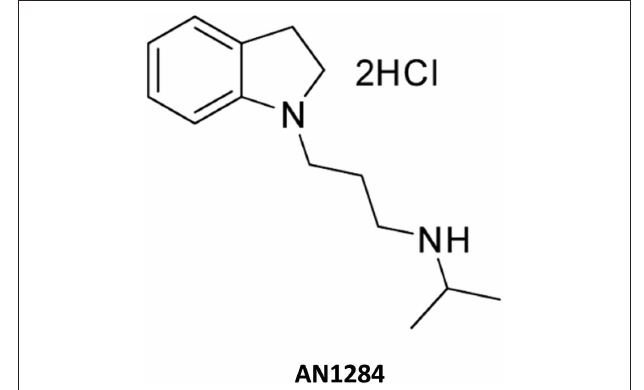
FIGURE 1 | The chemical structure of AN1284.